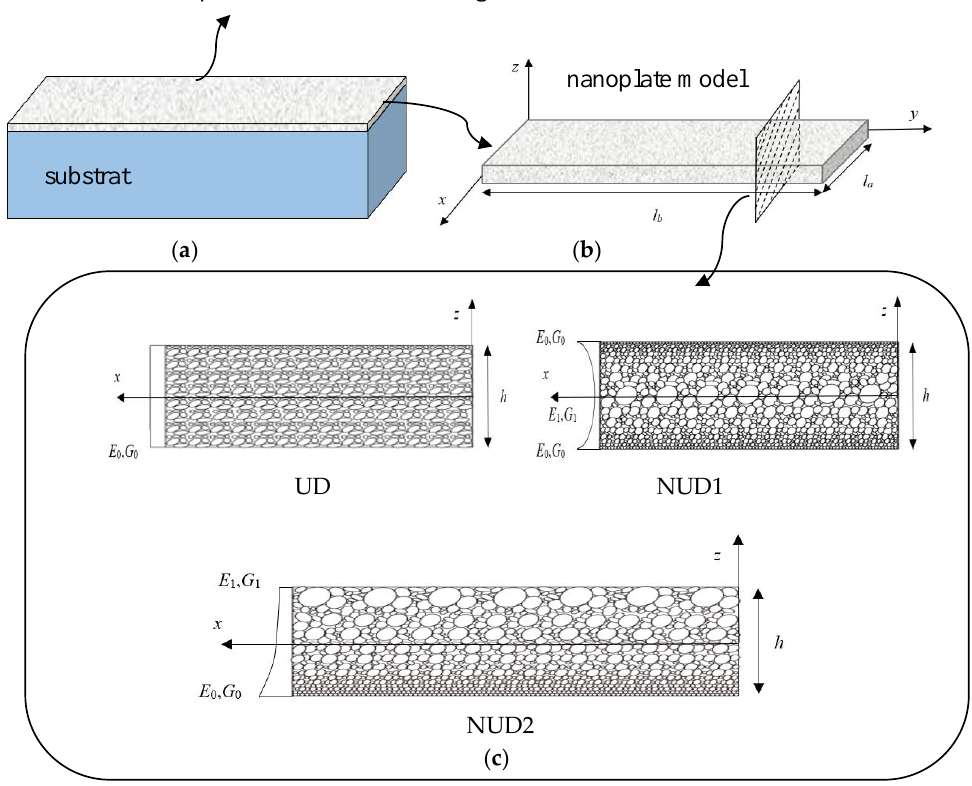
Figure 1. Functionally graded (FG) nanoporous metal foam nanoplate and three types of porosity distribution, namely (1) uniform distribution (UD), (2) non-uniform distribution 1 (NUD1) (symmetric), and (3) non-uniform distribution 2 (NUD2) with ( a ) coating on substrate, ( b ) nanoplate model, ( c ) cross section.